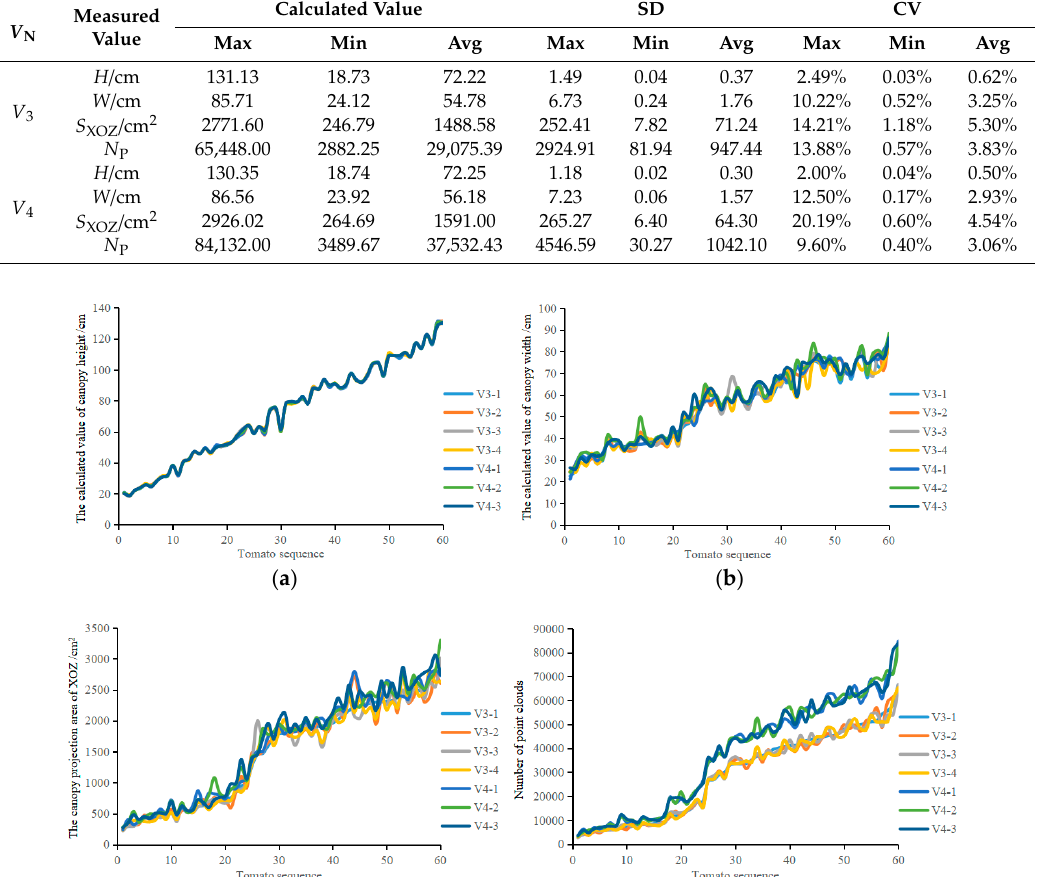
Table 2. E ff ects of di ff erent measurement methods on the calculated values of the canopy morphological parameters.